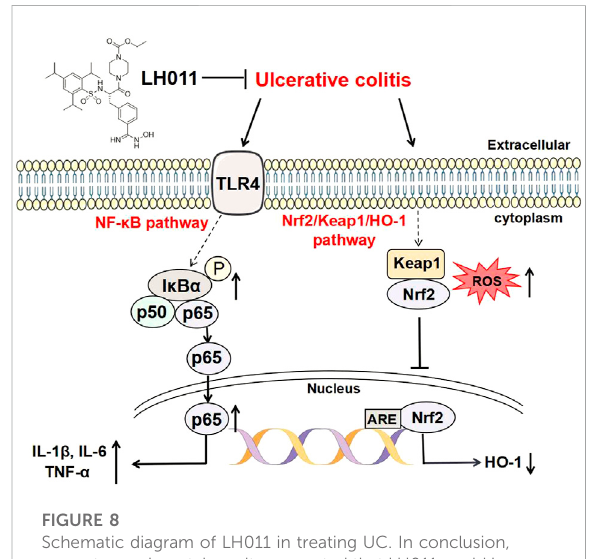
FIGURE 8 Schematic diagram of LH011 in treating UC. In conclusion, current experimental results suggested that LH011 could improve DSS-induced mice colitis. On the one hand, LH011 decreased in fl ammatory response by inhibiting the TLR/NF- κ B signaling pathway. On the other hand, LH011 enhanced anti-oxidant capacity by activating the Nrf2/Keap1/HO-1 signaling